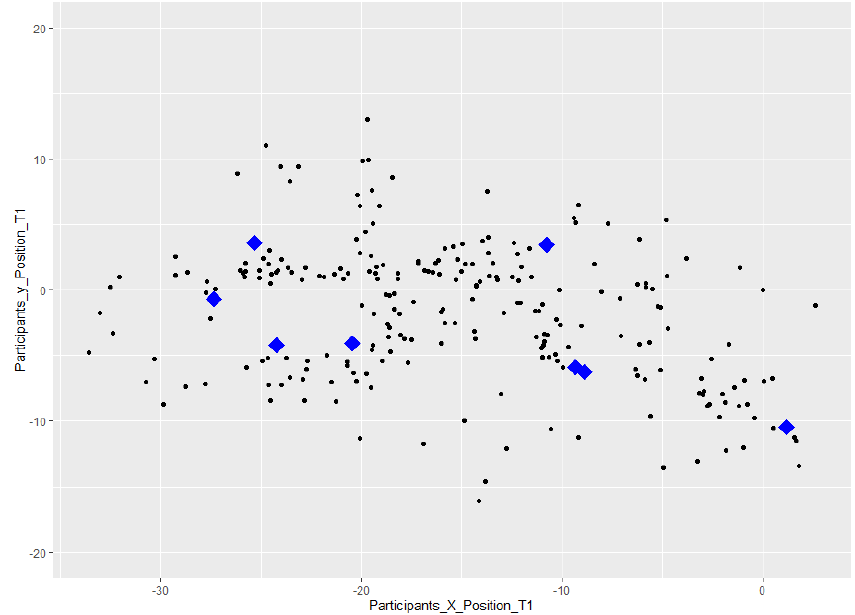
Figure 12. A visualization of participants’ change of position in Task 1; the 8 task targets are shown in blue.